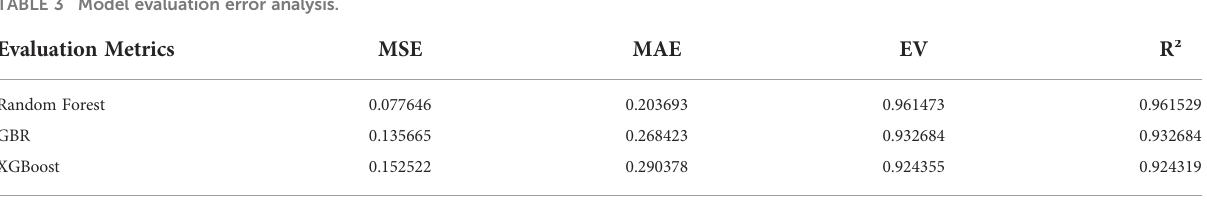
TABLE 3 Model evaluation error analysis.